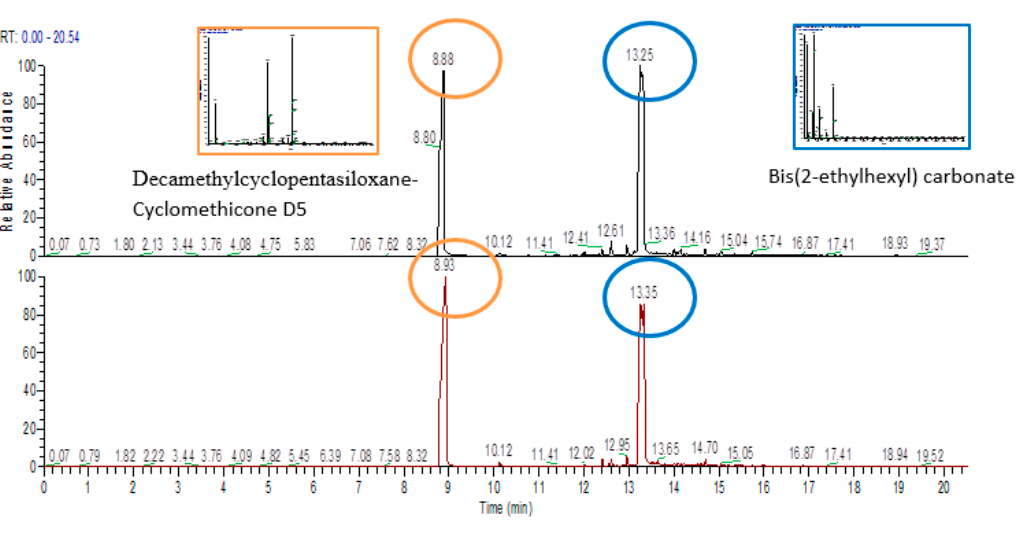
Figure 4. Chromatograms for ( top ) linear low-density polyethylene (LLDPE) and ( bottom ) low-density polyethylene (LDPE) single dose containers filled with simulant after simulated solar irradiation. (RT: retention time expressed in minutes).